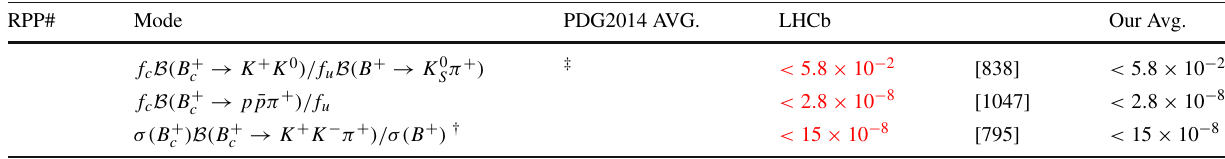
Table257 Relative branching fractions of B + c decays. Where values are shown in red (blue), this indicates that they are new published (preliminary) results since PDG2014